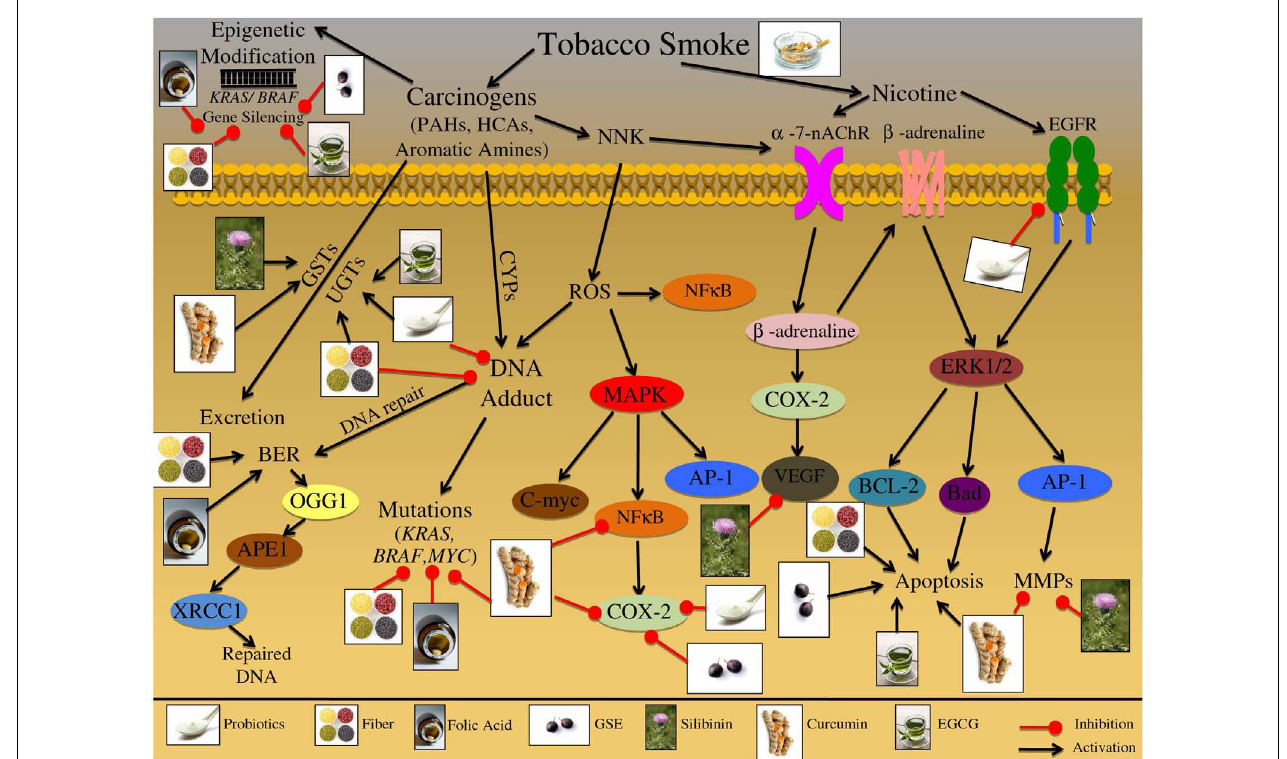
FIGURE 3 | Effect of cigarette smoke on the etiology of colon carcinogenesis . Cigarette smoke contains nicotine as well as numerous carcinogenic compounds that effect the initiation, promotion, and progression of colorectal cancer (CRC).These carcinogenic compounds include